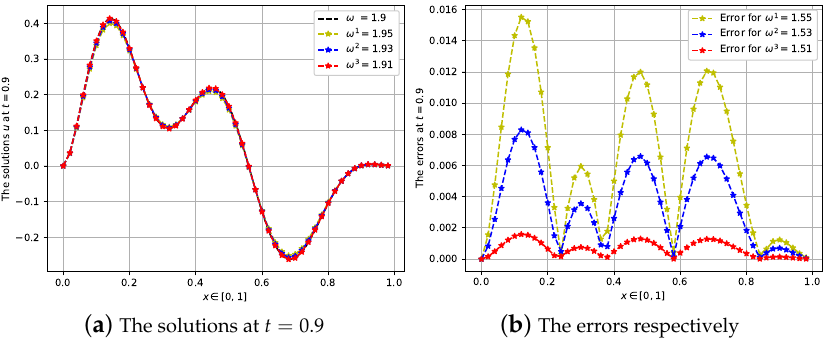
Figure 12. The solution u for ω = 1.9, ω i ∈ { 1.95,1.93,1.91 } at t = 0.9 and the respective